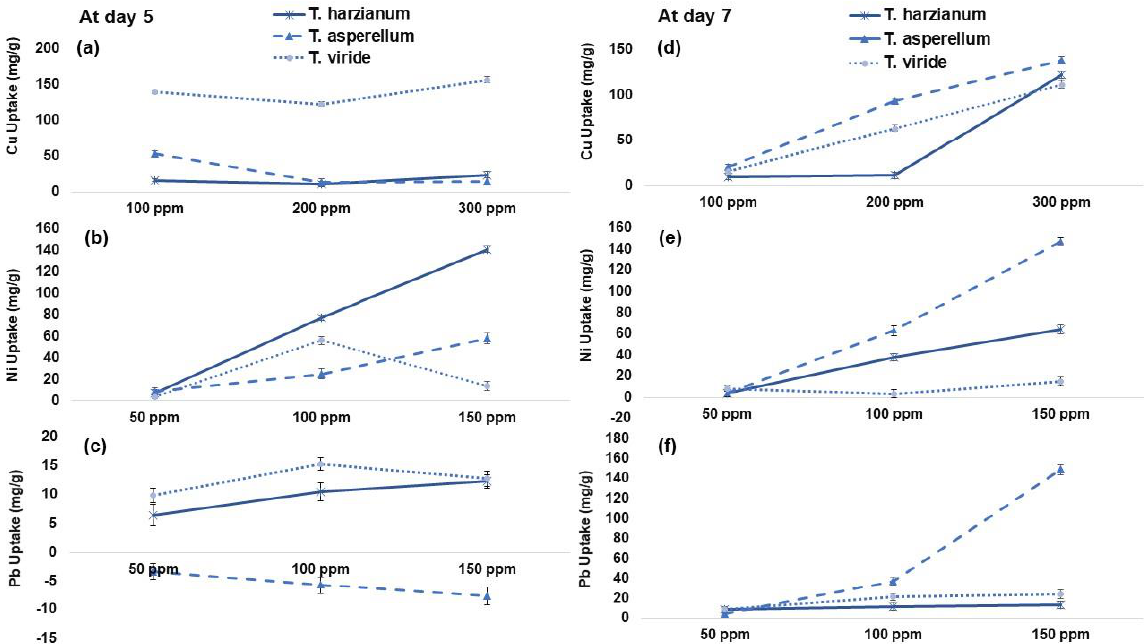
Figure 3. ( a – c ) Total copper (Cu), nickel (Ni) and lead (Pb) uptake per gram dry biomass of Tricho- derma harzianum (F1), Trichoderma asperellum (F2) and Trichoderma viride (F3) at day 5. ( d – f ) Total copper (Cu), nickel (Ni) and lead (Pb) uptake per gram dry biomass of Trichoderma harzianum (F1), Trichoderma asperellum (F2) and Trichoderma viride (F3) at day 7, respectively. Values are the average of three replicates.